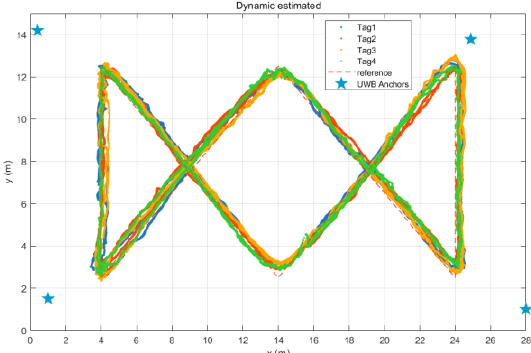
Figure 7. Comparison of estimated positions with reference ones.